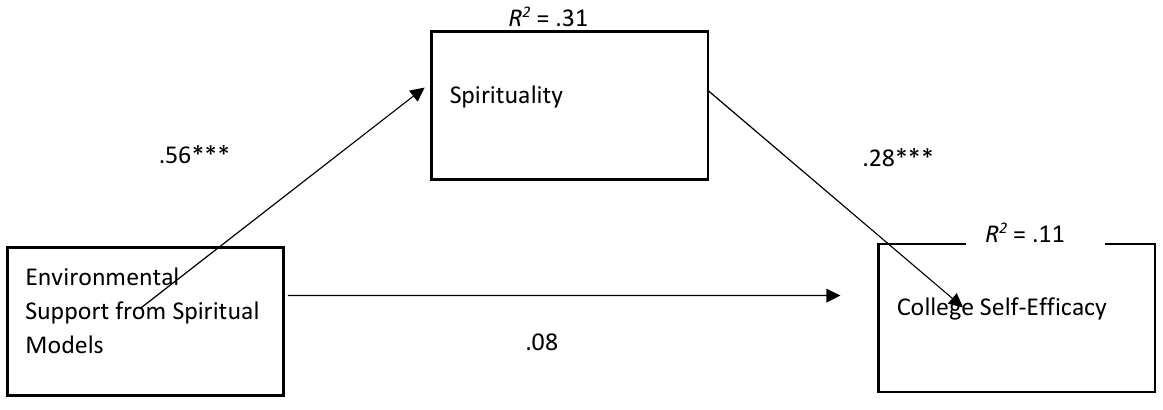
Figure 1. Mediation Path: Spirituality. Note. *** = p ≤